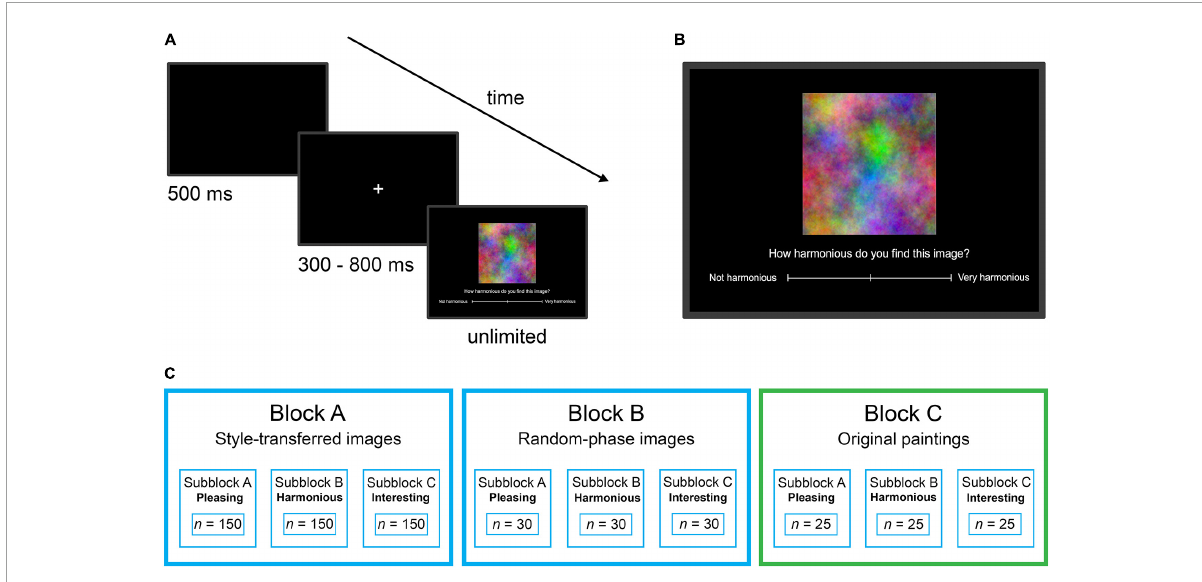
FIGURE2 Experimental procedure. The schedule is shown in (A) with the presentation times indicated below each screen shot. (B) Shows a magnification of the screen display where ratings are entered by a mouse click on the scale below the image. (C) Illustrates the sequence of the rating blocks. Within the blue boxes, images and block sequences were randomized while the green box indicates a fixed position. n , number of